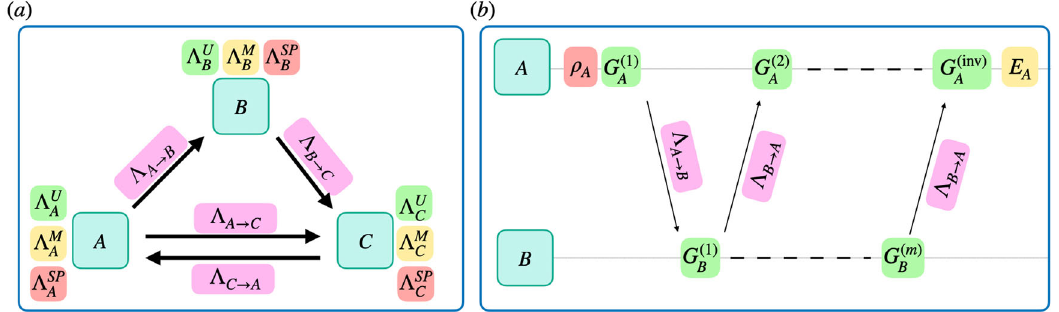
Fig. 1 The quantum network model. a An example network with three nodes A , B , and C presented together with all associated quantum channels modeling state preparation noise ( Λ SP ), measurement noise Λ M , operation noise ( Λ U ), and modeling noise in the network link connecting the node (e.g., Λ A → B for the link A → B ). b Graphical description of (a single run of m bounces of) the two-node network benchmarking protocol, with time running rightwards. Boxes indicate actions taken at nodes A , B , and colors (color online) associated